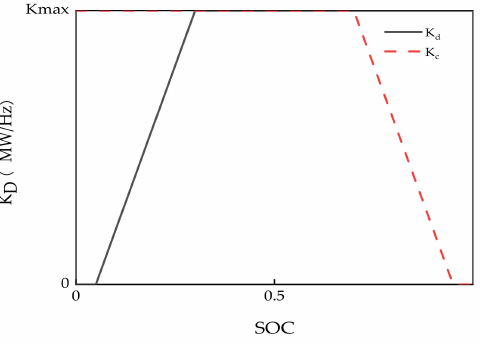
Figure 4. Droop coefficient changes in super-capacitor charge and discharge